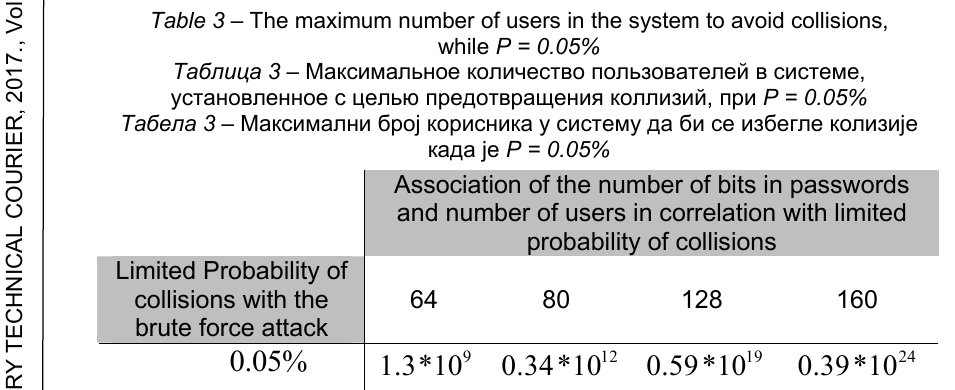
Table 3 – The maximum number of users in the system to avoid collisions, while P = 0.05%